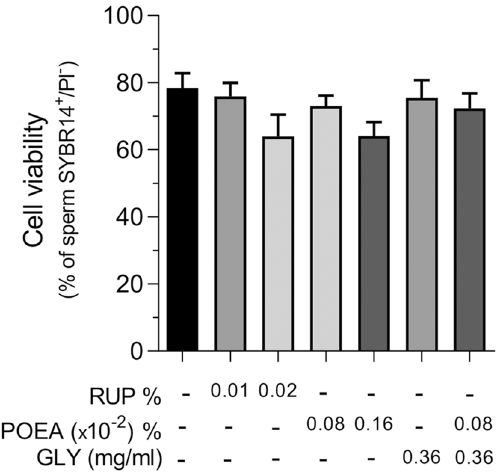
Figure 1. Effects of Roundup Ultra Plus (RUP), surfactant polyoxyethylene tallow amine (POEA) and Glyphosate (GLY) in human sperm viability. Spermatozoa were incubated in BWW for 1 h at 37 °C, 5% CO 2 , in the absence or presence of different concentrations of RUP (0.01%, 0.02%), POEA (0.0008%, 0.0016%), GLY (0.36 mg mL −1 ) or POEA (0.0008%) in combination with GLY (0.36 mg mL −1 ). This experiment was